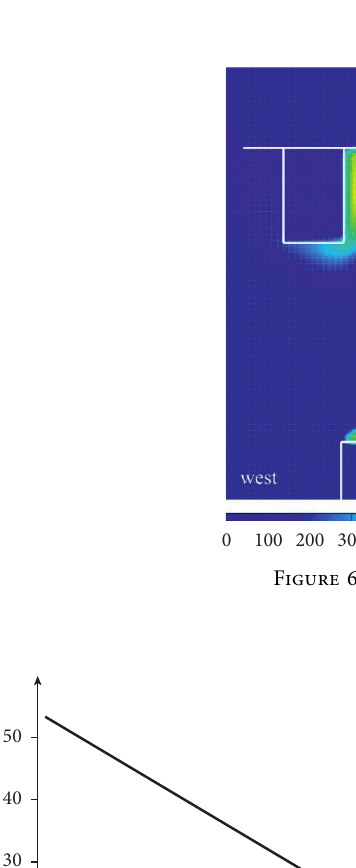
Figure 5: Gas temperature (elevation view).